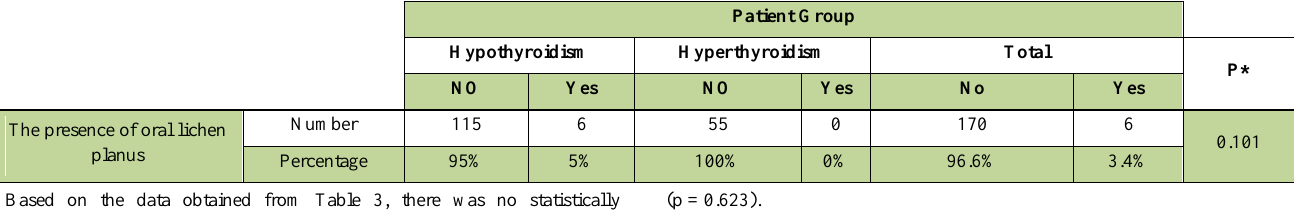
Table 2. Frequency of oral lesions in two patient groups.